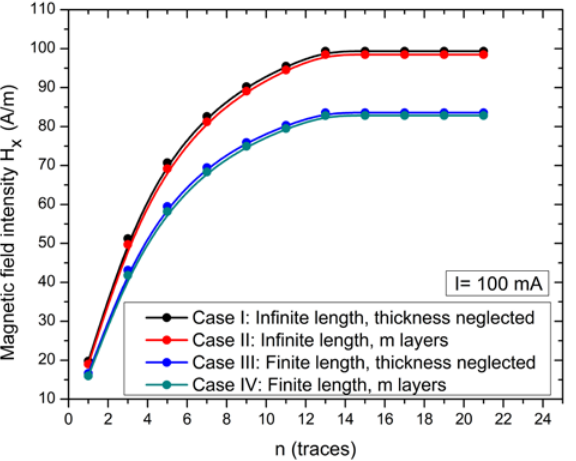
Figure 21. Magnetic field intensity obtained according to the analytical method in the sensor area, dependency on the number of traces in the case of a planar coil (the same parameters as for the 7 traces planar coil were used in this case). Note that m = 35 layers (1 μm each layer). Table 2. Comparative analysis between COMSOL simulation, analytical model, and experimental data. estimated value of the surface parallel component of the magnetic field in the sensor area varies between 30 and 39.68 A/m (between 0.4 and 0.48 Oe), depending on